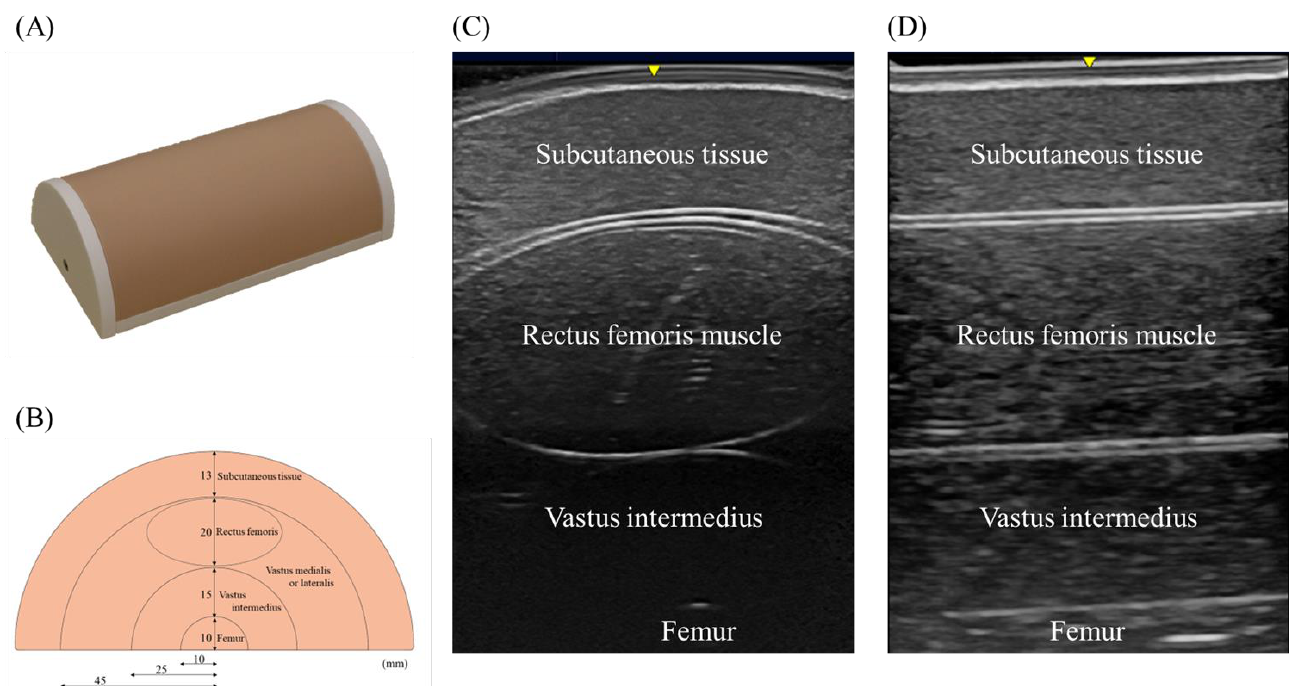
Figure 1. Ultrasound phantom of the rectus femoris muscle. ( A ) Phantom model image. ( B ) Cross-sectional structure of the phantom model; this phantom has a semicircle structure. From the surface of the vertical line surface, internal layers include subcutaneous tissue (13 cm), rectus femoris muscle (20 cm × 40 cm), vastus intermedius (15 cm), femur (10 cm), and at the same layer with rectus femoris muscle, vastus medialis or lateralis. ( C ) Cross-sectional ultrasound scanning image. ( D ) Longitudinal ultrasound scanning image.